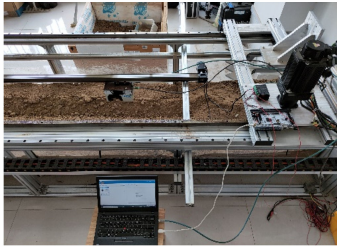
Figure 4. Measuring device.